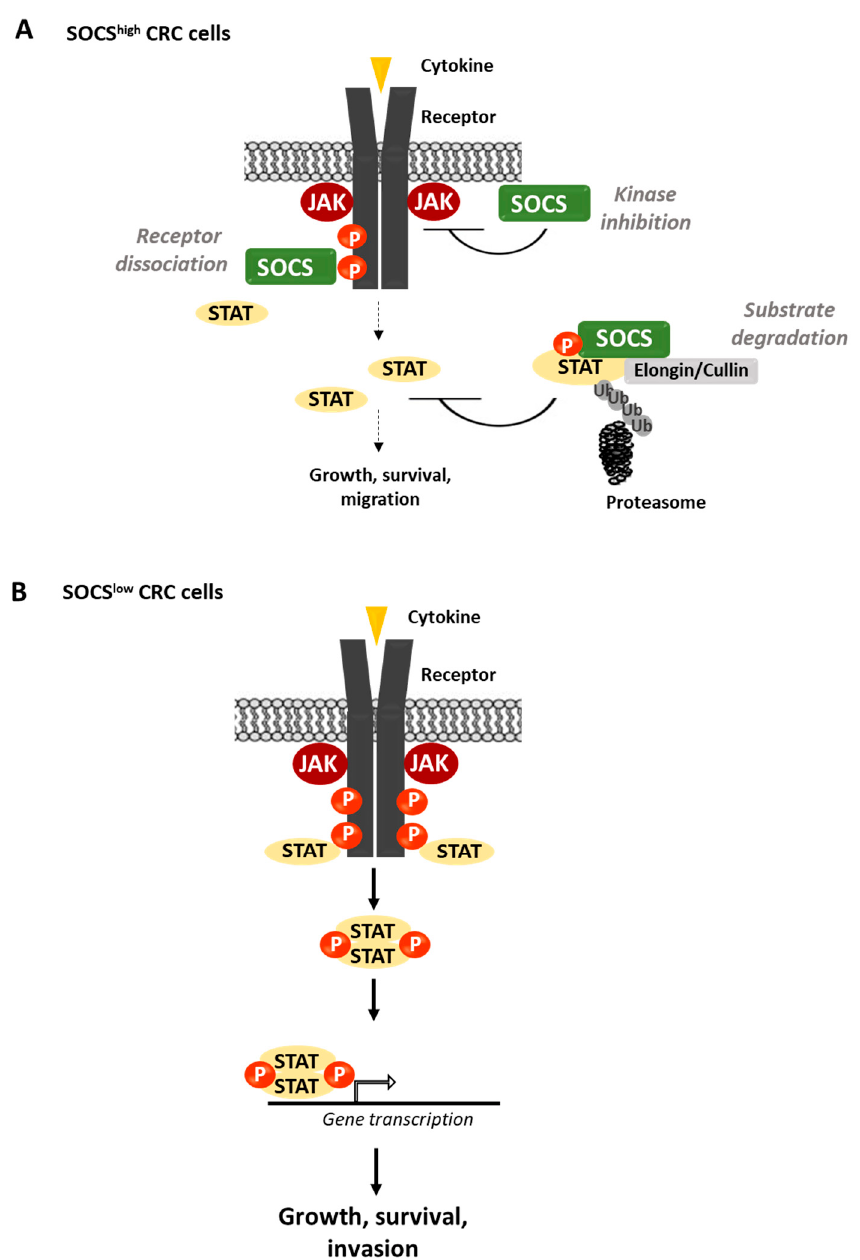
Figure 5. Model depicting how SOCSs can counteract JAK / signal transducer and activator of transcription (STAT) signalling in CRC cells. ( A ) In CRC cells that express SOCS, these adaptors can inhibit STAT phosphorylation by preventing its association with the receptor, promoting its proteasomal degradation or inhibiting JAK kinase activity through direct binding. ( B ) SOCS downregulation in CRC cells, by gene promoter methylation or epigenetic mechanisms, leads to aberrant JAK / STAT signalling that promotes tumour cell growth and migration. Ub, ubiquitin; P, phosphorylation.